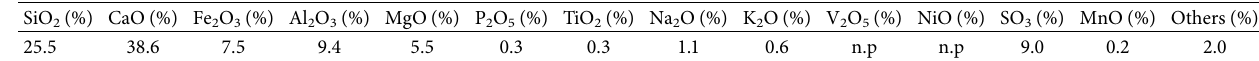
Figure 1: (a) Map of the Republic of Kosovo, (b) lignite layers, and (c) photo of coal FA (Kosovo A). Table 1: Data on coal FA (Kosovo A).